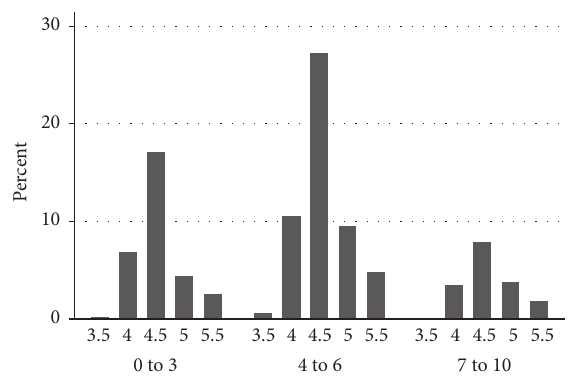
Figure 2: % distribution by pH and Nugent